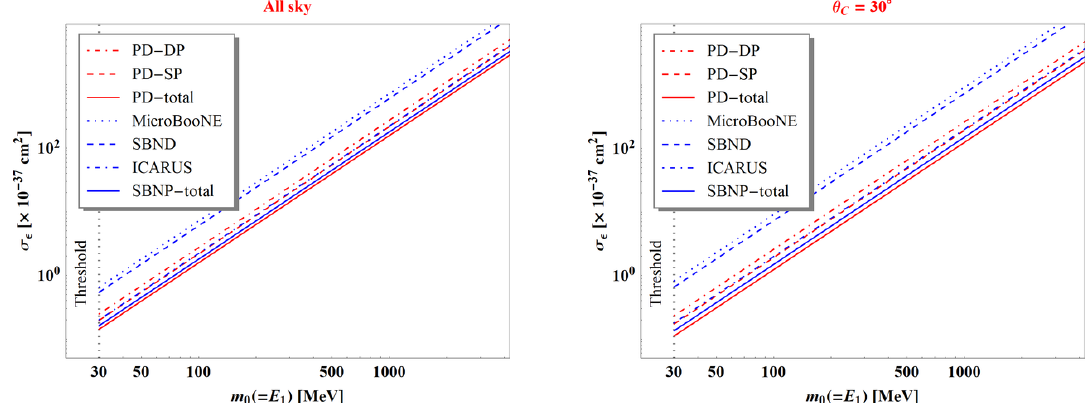
Figure 5 . The 90% C.L. experimental sensitivities to the elastic BDM signal via electron scattering at the detectors listed in table 2, together with h (cid:27)v i (cid:31) = 5 (cid:2) 10 (cid:0) 26 cm 3 s (cid:0) 1 (i.e., annihilation 0 (cid:31) 0 ! (cid:31) 1 (cid:31) 1 scenario of BDM). Assumed is one-year exposure from all sky (left panel) and a 30 (cid:14) cone (right panel). The vertical black dotted lines denote the threshold energy for electrons. We take a conservative value of 30 MeV for SBN Program